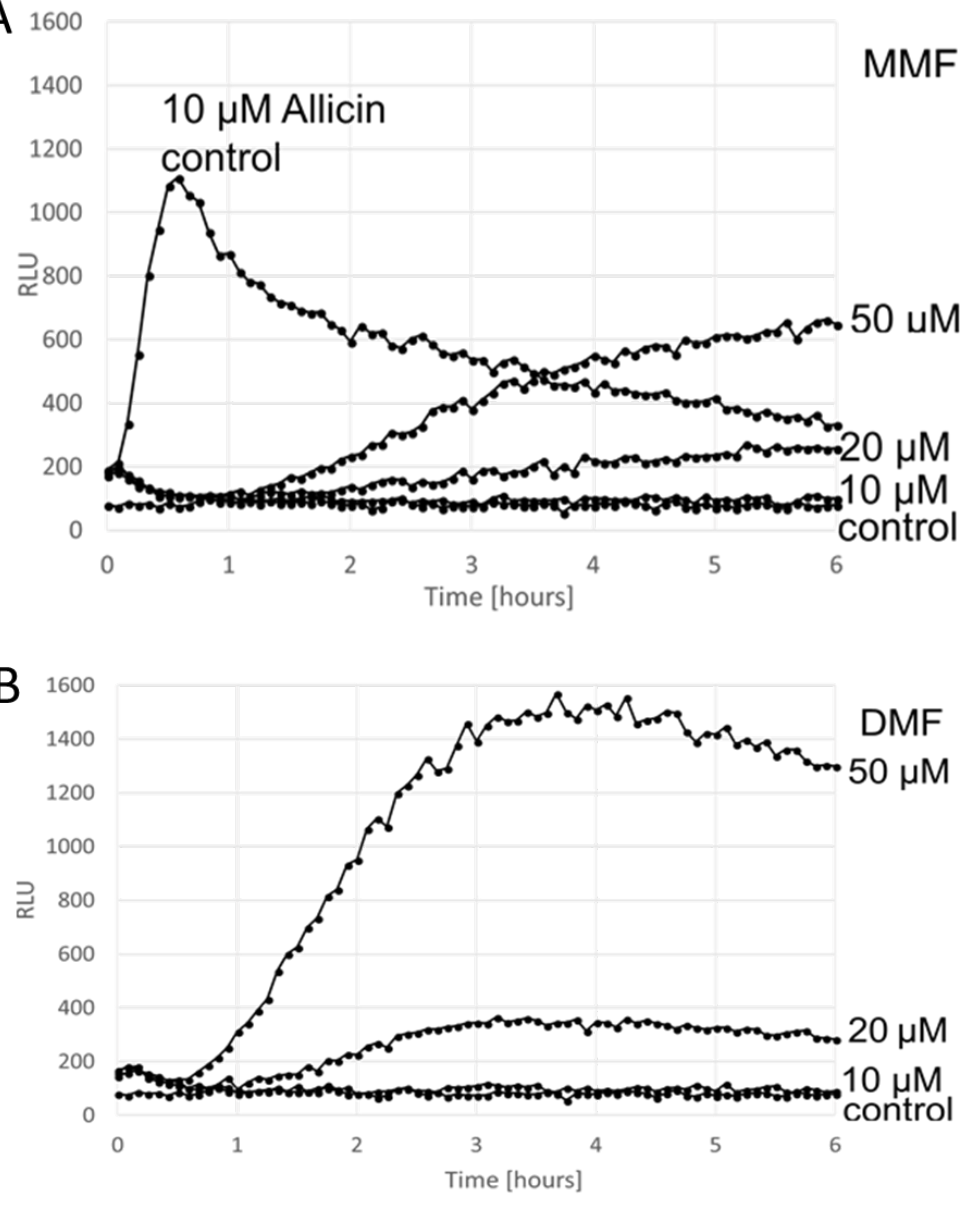
Figure 3. Dynamic response of yeast cells containing the OSI1::luciferase reporter to ( A ) monomethyl fumarate (MMF) ( B ) dimethyl fumarate (DMF). MMF and DMF were dissolved in DMSO. In the assay was 5% ( v/v ). n = 3. RLU is the abbreviation for Relative Luminescence Units.